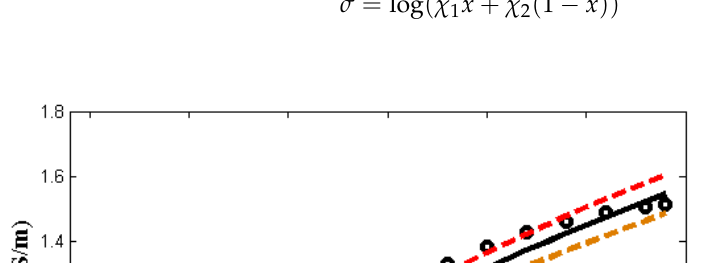
Table 5. Gaussian fitting performance data (n = 2).